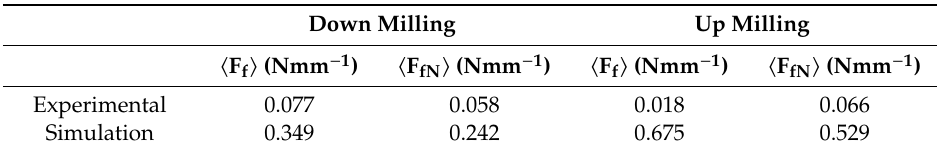
Table 8. Scaled average reaction forces for the peripheral milling (Model A, v c = 100 m / min, f z = 0.05 mm).